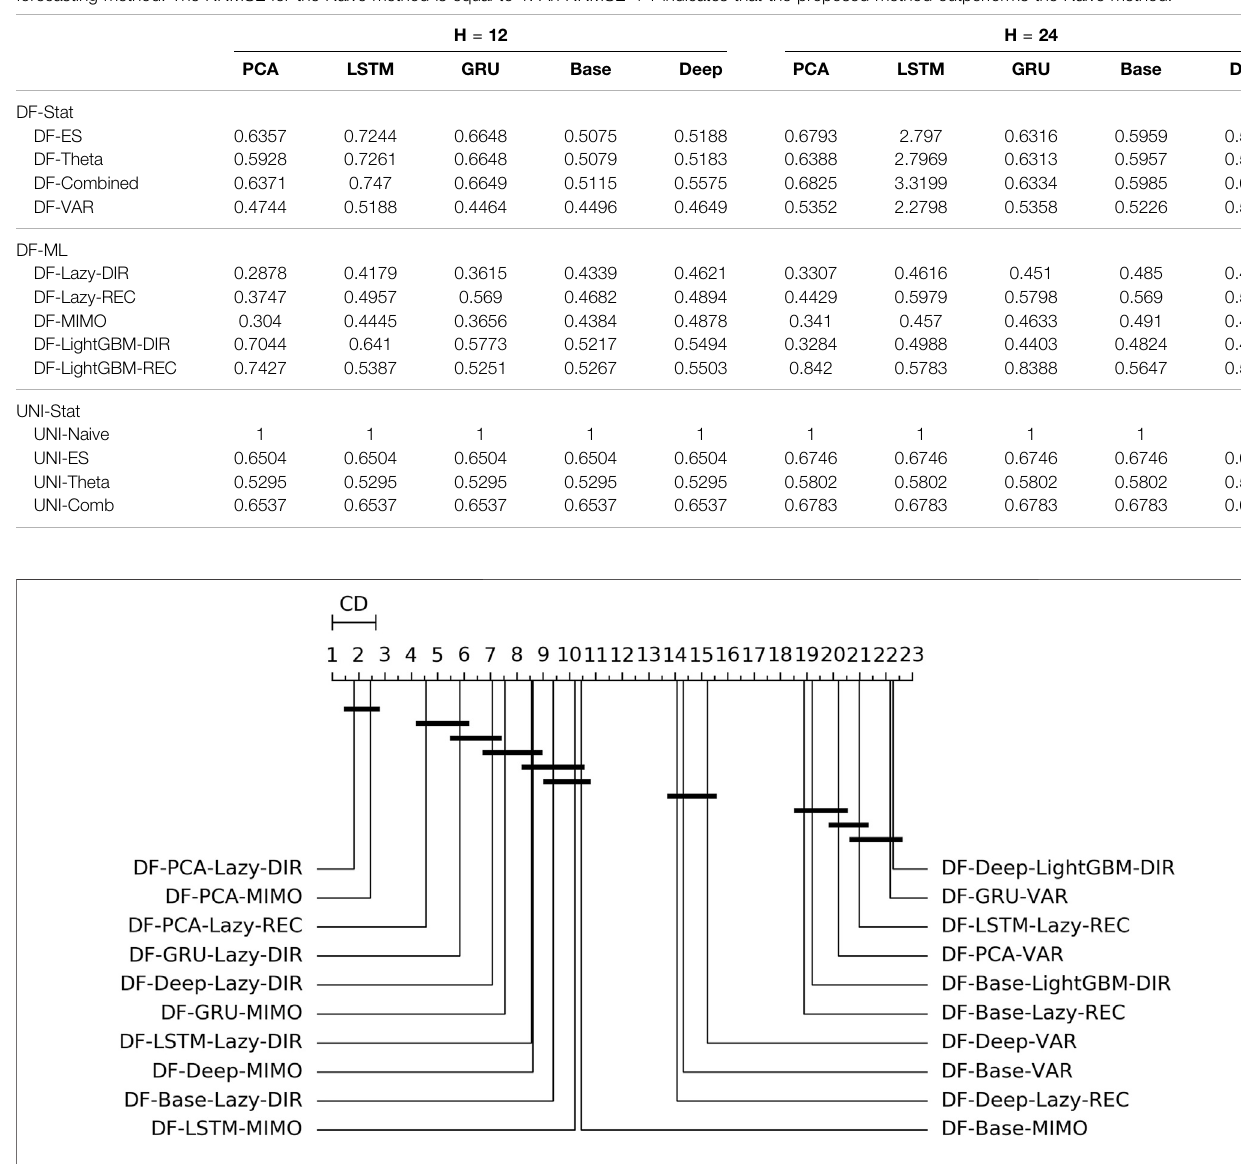
Frontiers in Big Data |